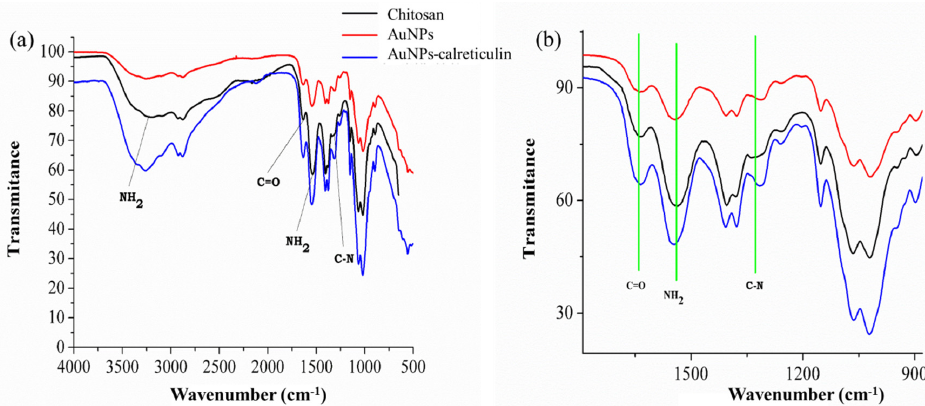
Figure 2. IR spectrum of chitosan, AuNPs, and AuNPs–calreticulin. ( a ) Characteristic peaks of chitosan were observed. ( b ) Detail of attenuated total reflection (ATR)– Fourier transform infrared spectroscopy (FTIR) spectra between 900–1600 cm − 1 shows the principal peak shifts of the interaction between calreticulin and chitosan. Table 2. Functional groups of chitosan.